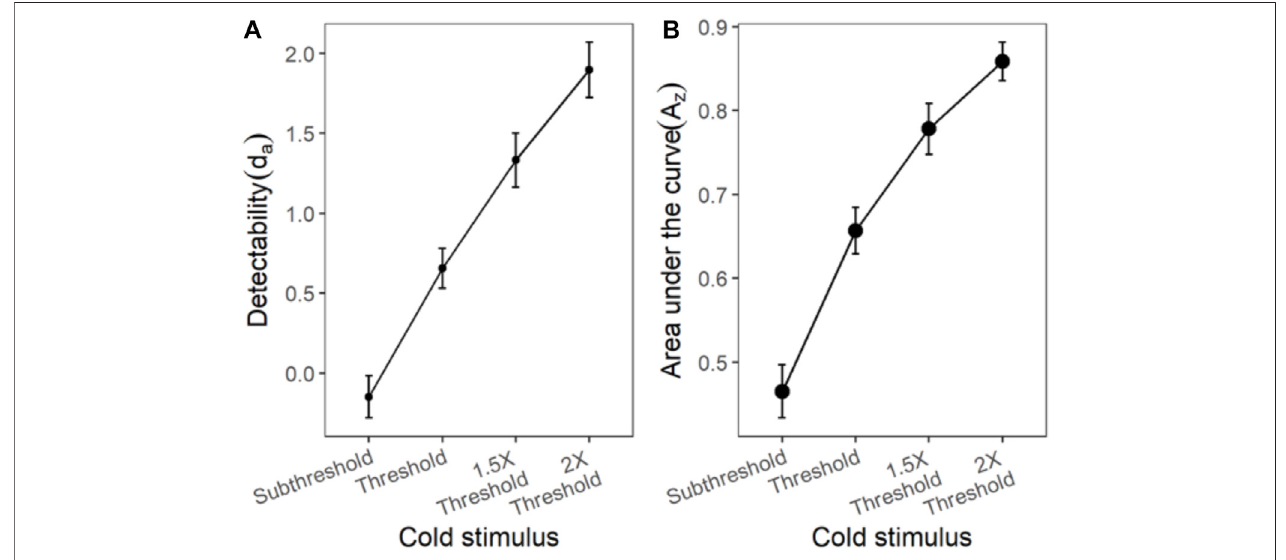
FIGURE5| Thed a andA z transducerfunctionsforcoldstimuli.Eachhorizontalaxisisstimulusintensityandintheleft-handpanel,the y -axisisdetectability(d a )and in the right-hand panel, the y -axis is area under the curve (A z ). The points are the means and error bars are the SE of the estimates.